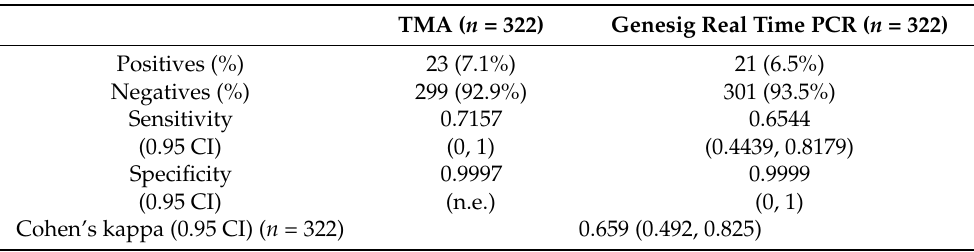
Table 3. Test characteristics as calculated by LCA and agreement of the TMA assay and the Genesig real-time PCR assay.